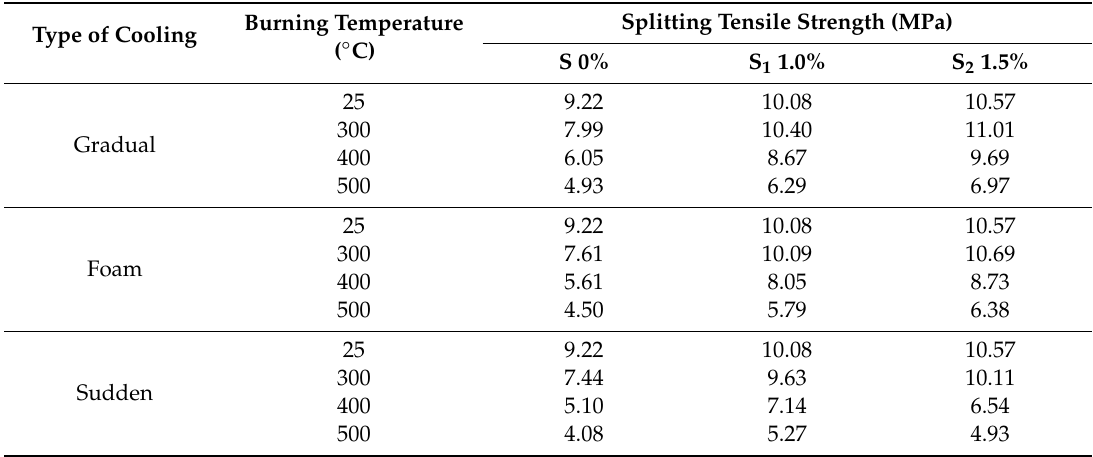
Table 8. Splitting tensile strength results concerning all types of cooling for the adopted RPC mixes.